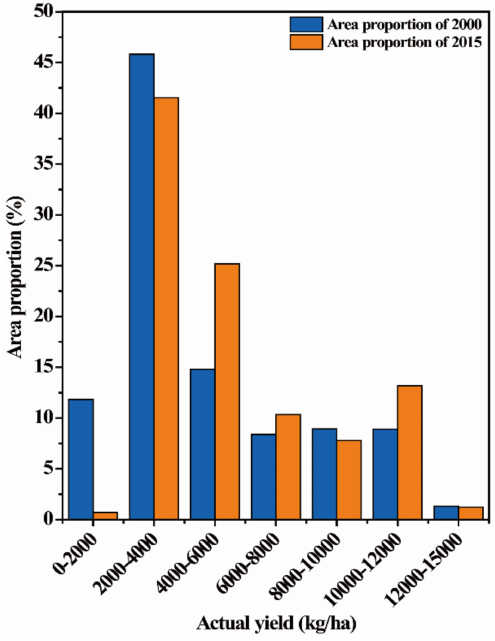
Figure 10. Interval distribution of the mixed actual grain yield, i.e., rice, wheat, maize, soybean, and potato, in 2000 and 2015.